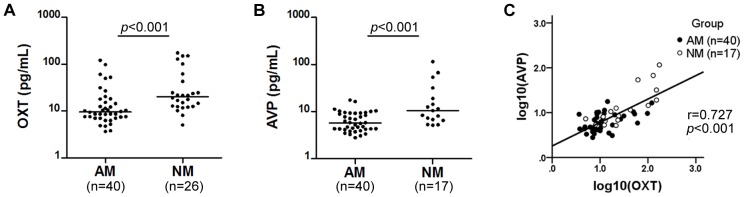
Plasma OXT and AVP levels and linear regression analysis.Median value for each group is shown by a horizontal bar. Mothers of autistic children displayed a significantly lower plasma level of OXT when compared to mothers of normal children (A). Plasma AVP levels were also significantly reduced in mothers of autistic children compared to mothers of normal children (B). A positive correlation was shown between log-transformed plasma OXT levels and log-transformed plasma AVP levels (r = 0.727, p<0.001) (C). AM: mothers of autistic children; NM: mothers of normal children; OXT: oxytocin; AVP: Arg-vasopressin.